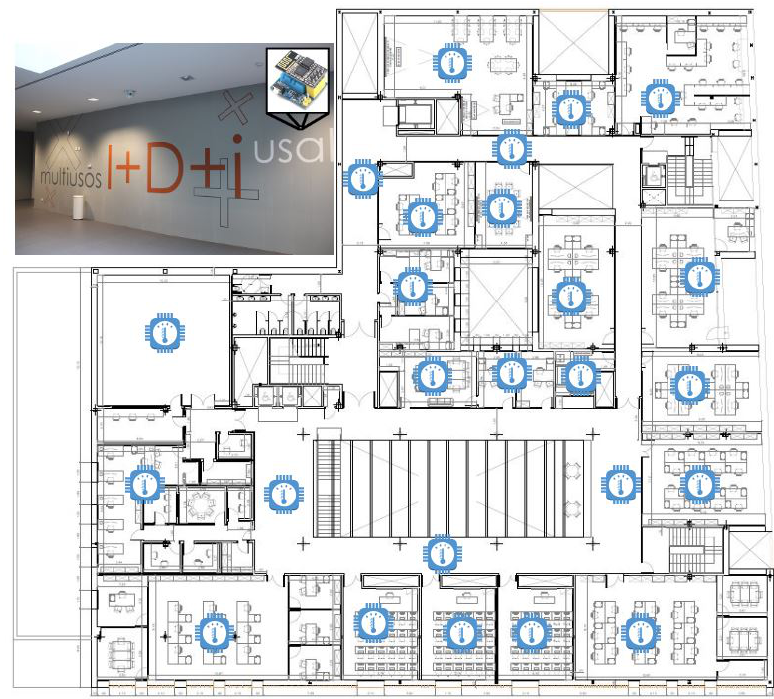
Figure 2. A map of the smart building used in the case study. The blue symbols in the figure are the positions in which the IoT devices are placed; they collect temperature